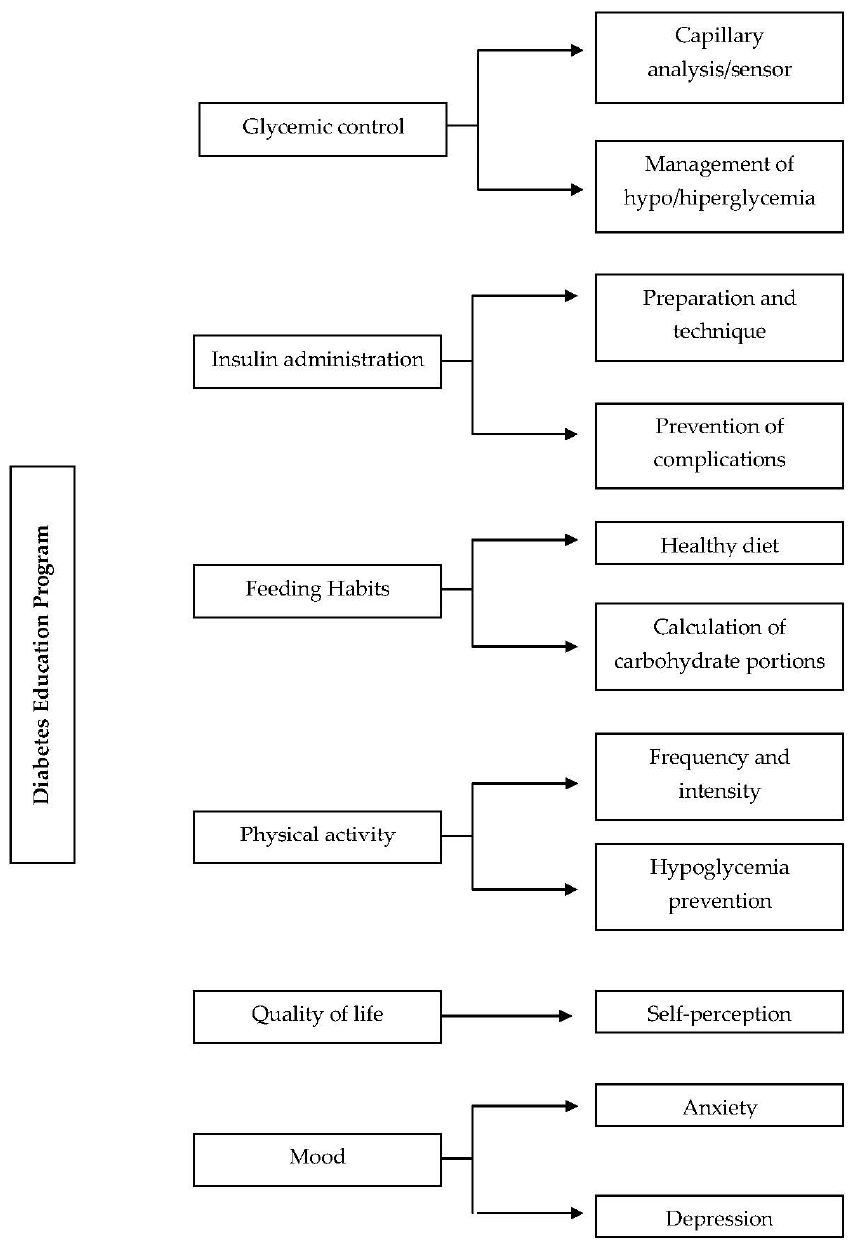
Figure 1. Code trees